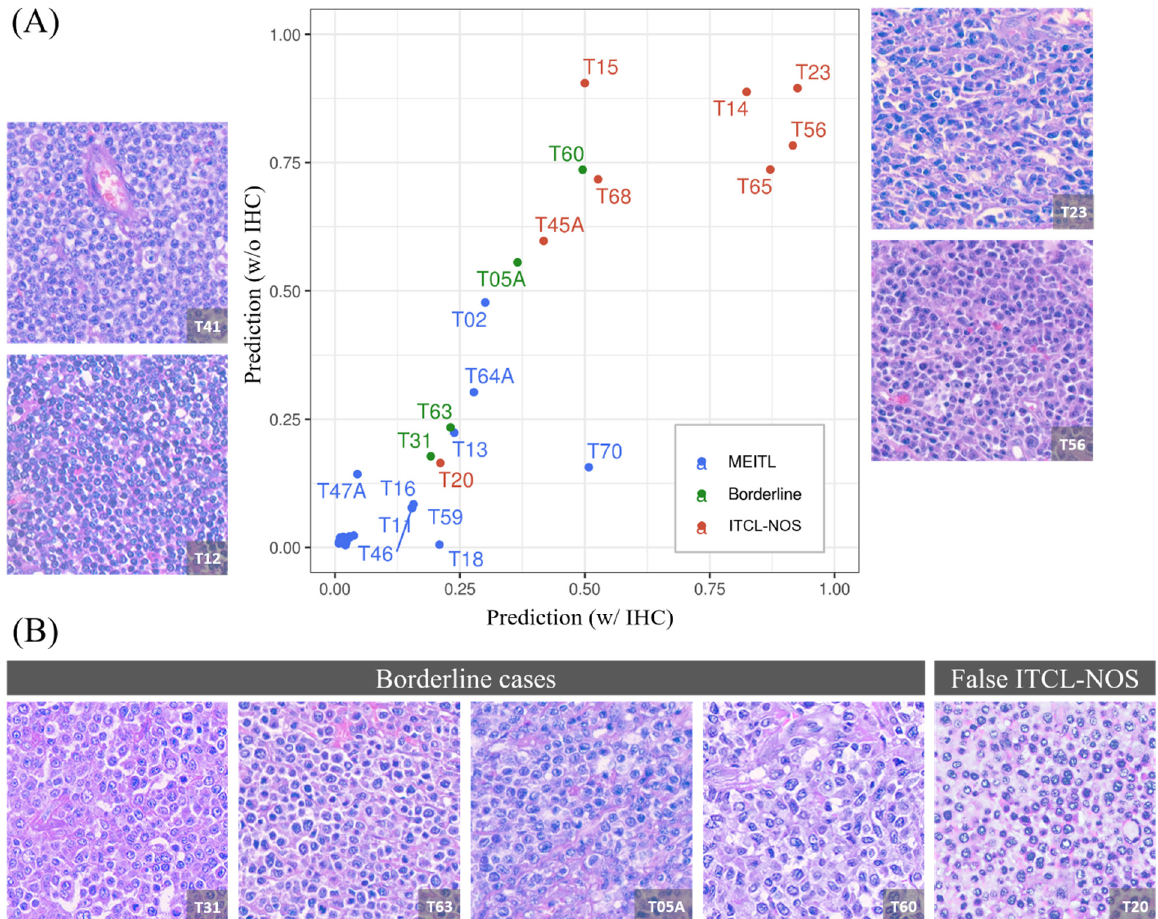
Figure 3. Association between predictions from two XGBoost models. ( A ) The scatter plot of predictions made by the two XGBoost models using morphological features with IHC (w/IHC) versus morphological features without IHC phenotype (w/o IHC). MEITL, ITCL-NOS, and borderline cases are represented by blue, red, and green, respectively. The representative images of typical MEITL (case no. T41 and T12) and ITCL-NOS (case no. T23 and T56) are presented. ( B ) The four borderline cases (case no. T31, T63, T05A, and T60) and a wrongly predicted case (case no. T20, predicted as MEITL but actually ITCL-NOS) are shown in the lower panels.